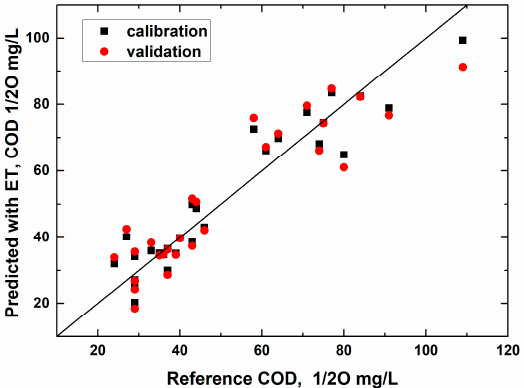
Figure 4. Measured vs. predicted plot of the PLS regression model for chemical oxygen demand (COD) based on three latent variables. Parameters of calibration/validation: slope 0.90/0.85; offset 5.0/7.4; RMSE 7.1/9.1; R 2 0.90/0.85.